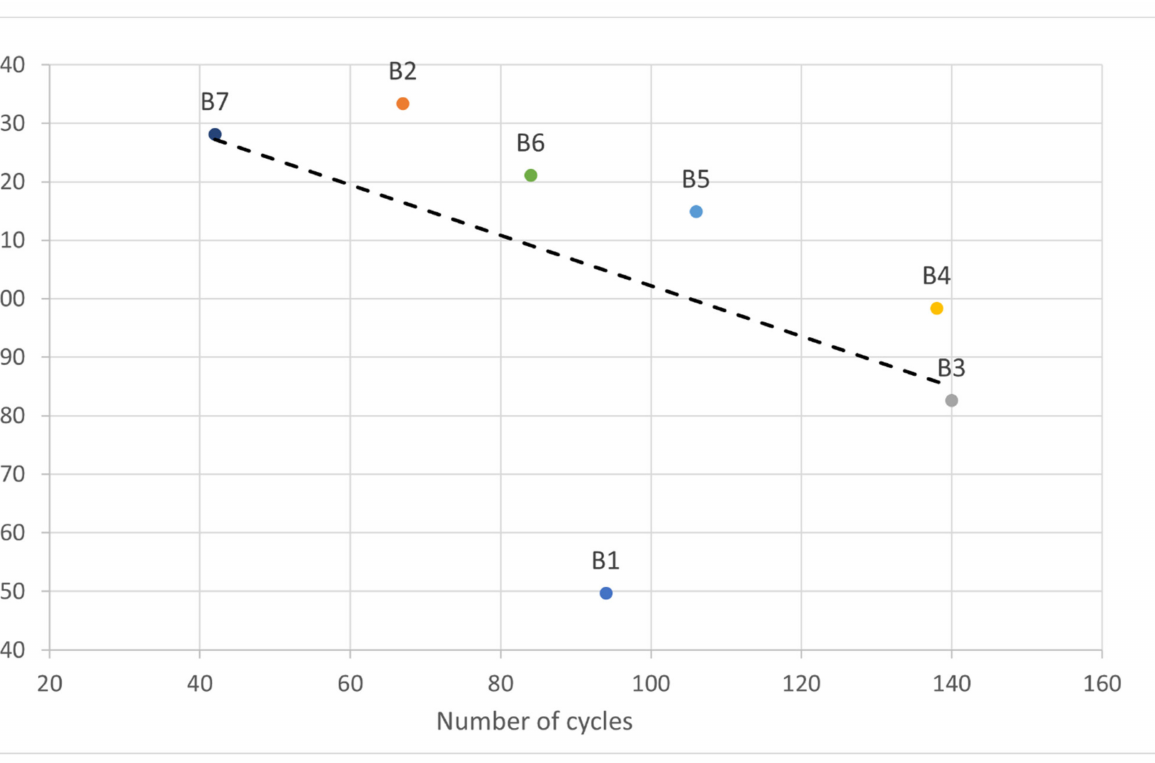
Figure 6. Depth of discharge vs. cycle